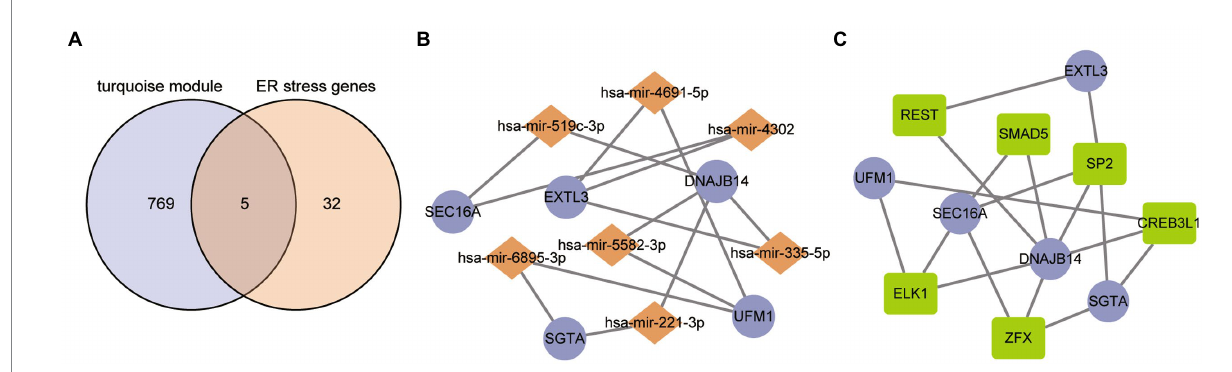
FIGURE 4 TF/miRNA-hub gene interaction network. (A) Hub ER stress regulators representation through a Venn diagram. (B) Network for miRNA interaction with hub ER stress regulators. The purple nodes represent the hub ER stress regulators and the other nodes represent miRNAs. (C) Network for TF interaction with hub ER stress regulators. The purple nodes represent the hub ER stress regulators and the other nodes represent